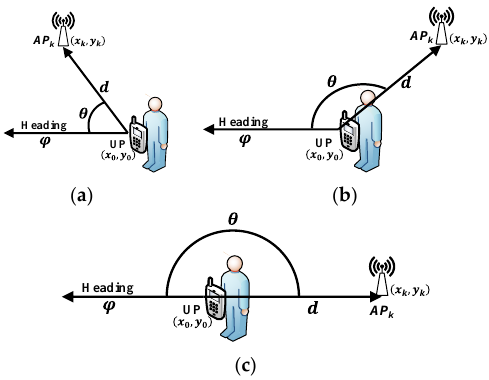
Figure 6. Body-shadowing detection strategy diagram: ( a ) diagram of the front condition; ( b ) diagram of the side condition; ( c ) diagram of the back condition.